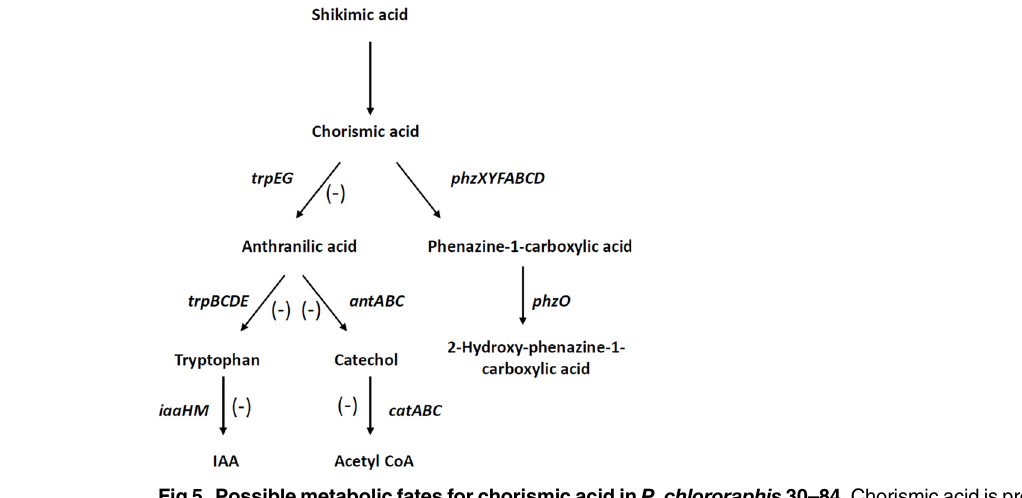
Fig 5. Possible metabolic fates for chorismic acid in P . chlororaphis 30 – 84. Chorismic acid is produced via the shikimic acid pathway and is a metabolic precursor for a number of different end products in pseudomonads, including phenazines (indicated by solid lines). The negative symbols (-) indicate competing pathways in which transcript levels for key genes are reduced in 2-OH-PCA producing strains compared to 30-84ZN (Table